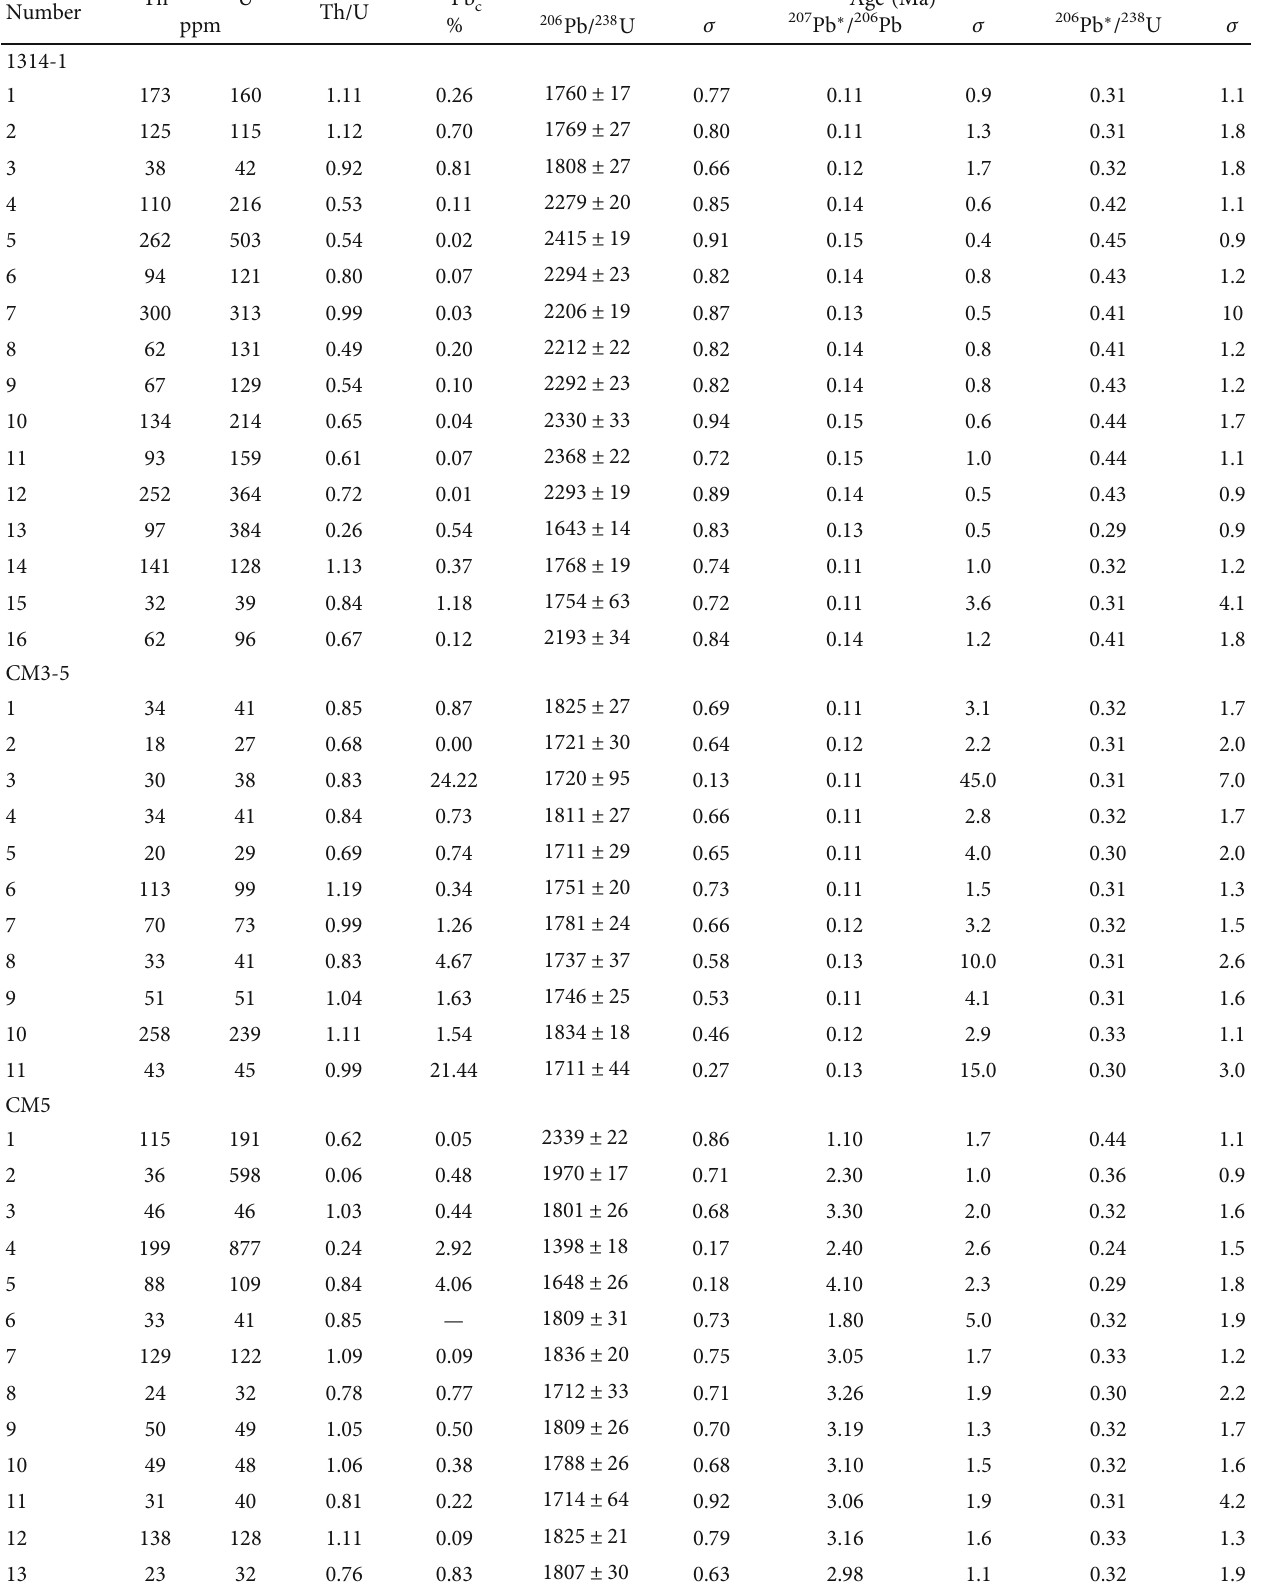
Table 1: Zircon U – Pb isotope test